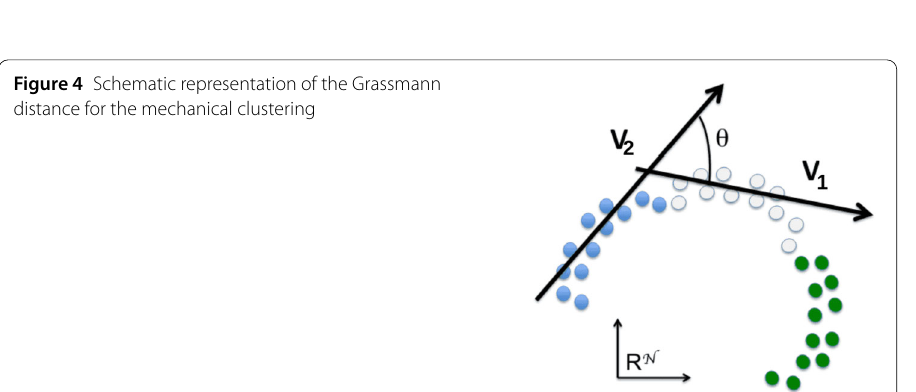
Figure 4 Schematic representation of the Grassmann distance for the mechanical